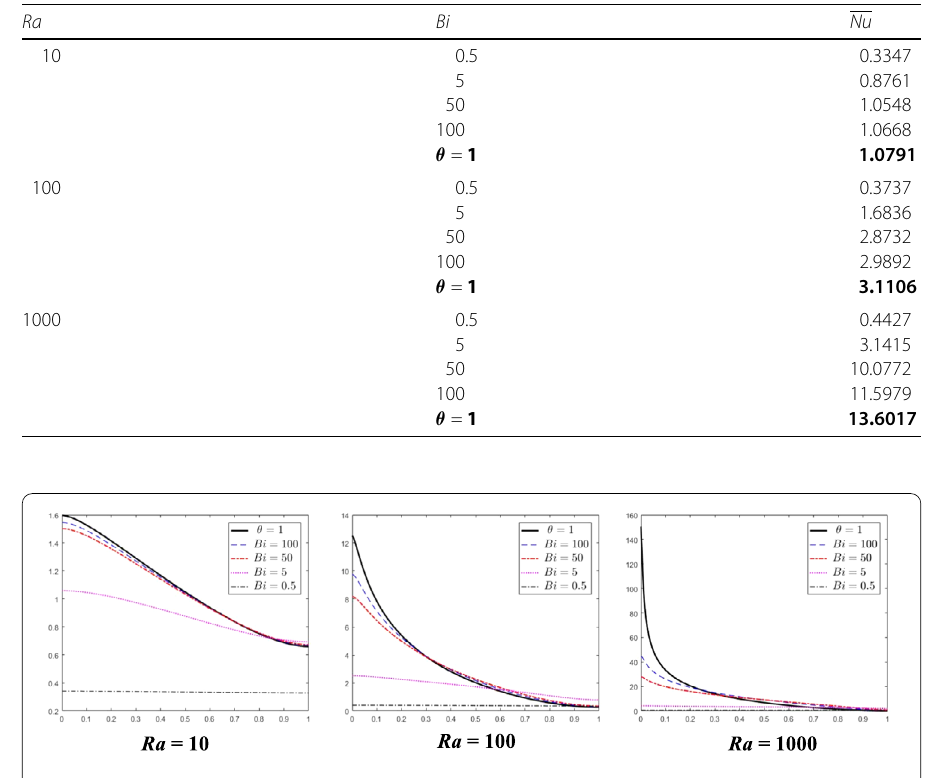
Table 5 Variation of Nu with Bi , for Ra = 10, 100, 1000, uniform grid Ra